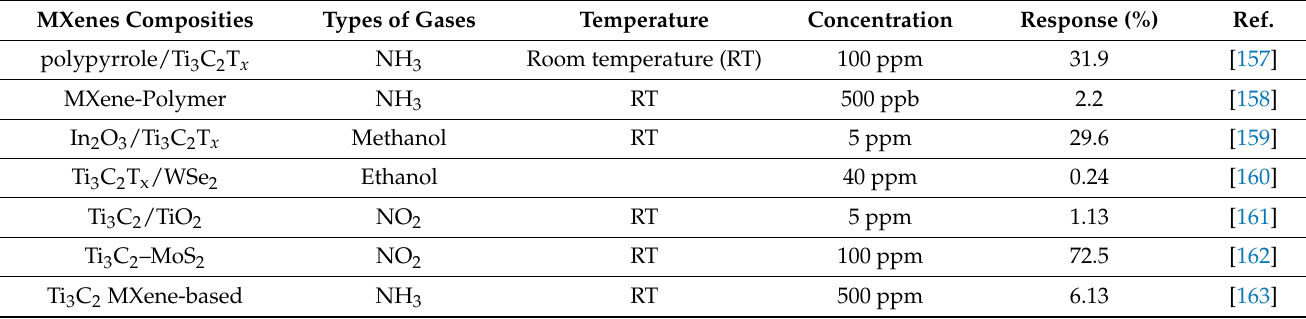
Table 5. Summary of the MXene-based composites for gas sensing